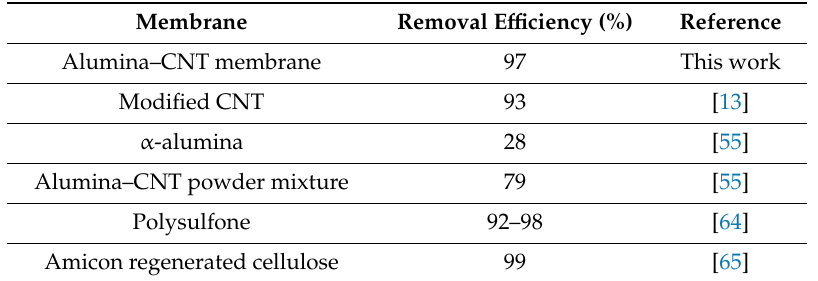
Table 2. Removal e ffi ciency of Cd (II) by di ff erent membranes as reported in the Table 2 . Removal efficiency of Cd (II) by different membranes as reported in the literature .